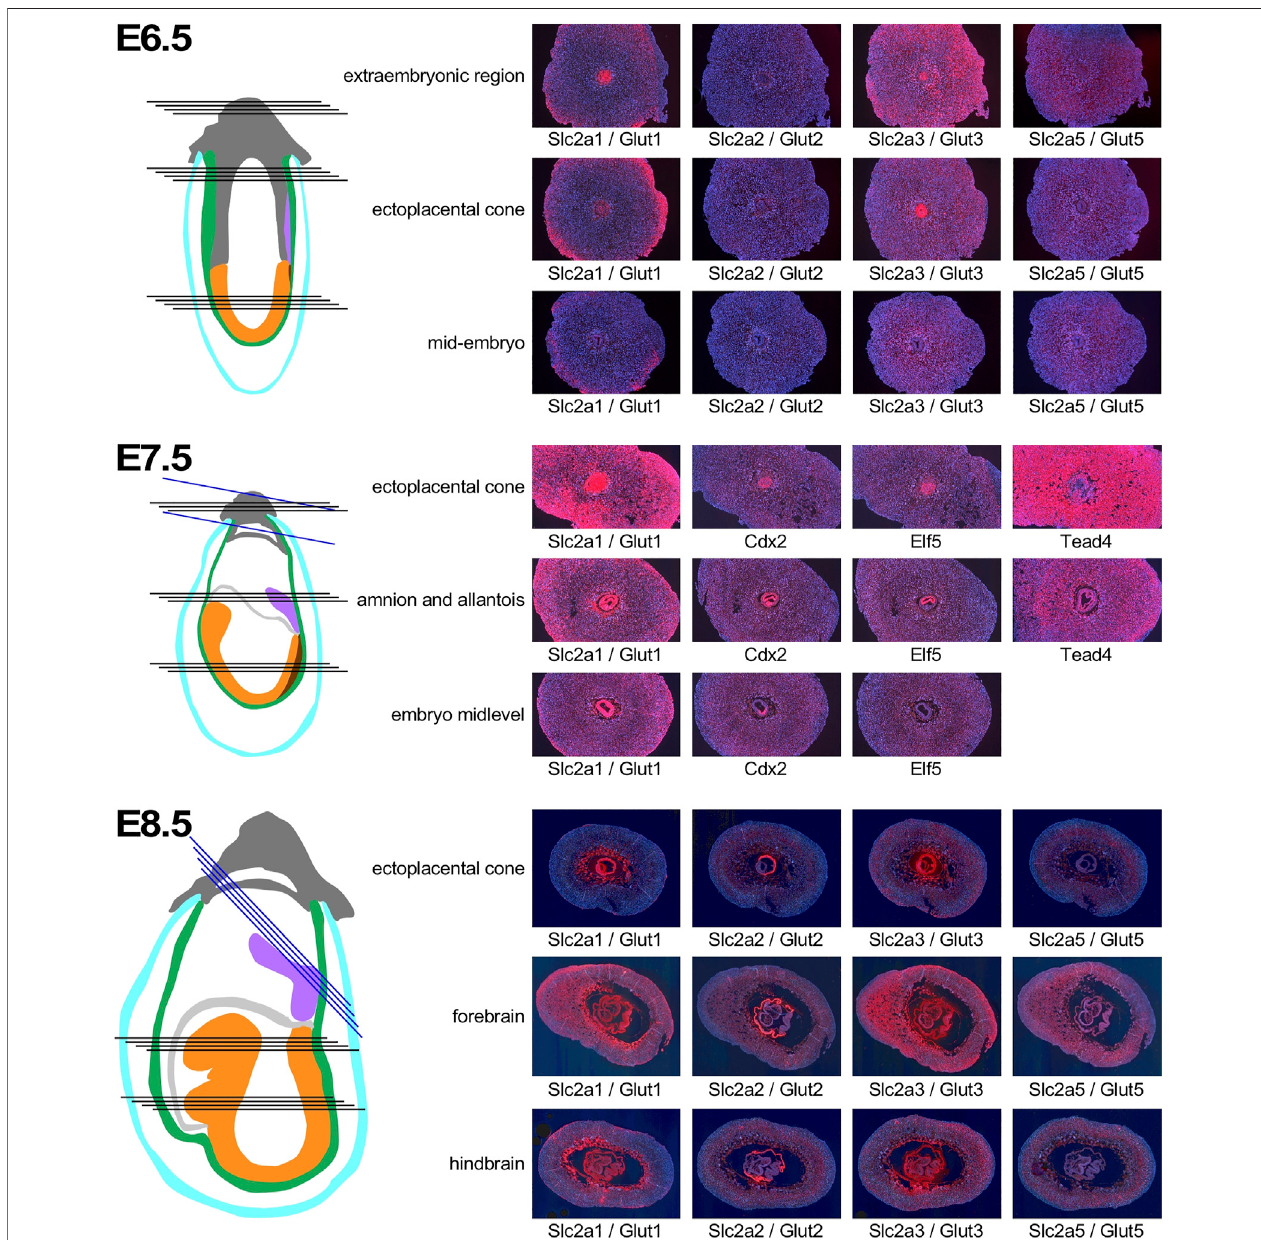
FIGURE 4 | Expression of Glucose transporter genes in early pregnancy. Decidua from pregnant females of the NOD mouse strain were isolated at various time pointsofpregnancy,andserialsectionswereproduced.AdjacentsectionsfromdifferentanatomicallocationswerehybridizedwithRNAscopeprobesfortherespective nutrient transporters. Schematic representations indicate the orientation of sections through tissues of the implantation sites: dark grey: extraembryonic cells and ectoplacentalcone;turqoise:parientalyolksac;green:visceralyolksac,purple:allantois;lightgrey:amnion;orange:embryoproper;brown:primitivestreak.Black lines indicate sections produced from the same implantation site, blue lines indicate sections from a different sample for the Tead4 hybridization at E7.5, and the ectoplacental cone sections at E8.5. Where possible, embryo sections are oriented with anterior (head) to the left.